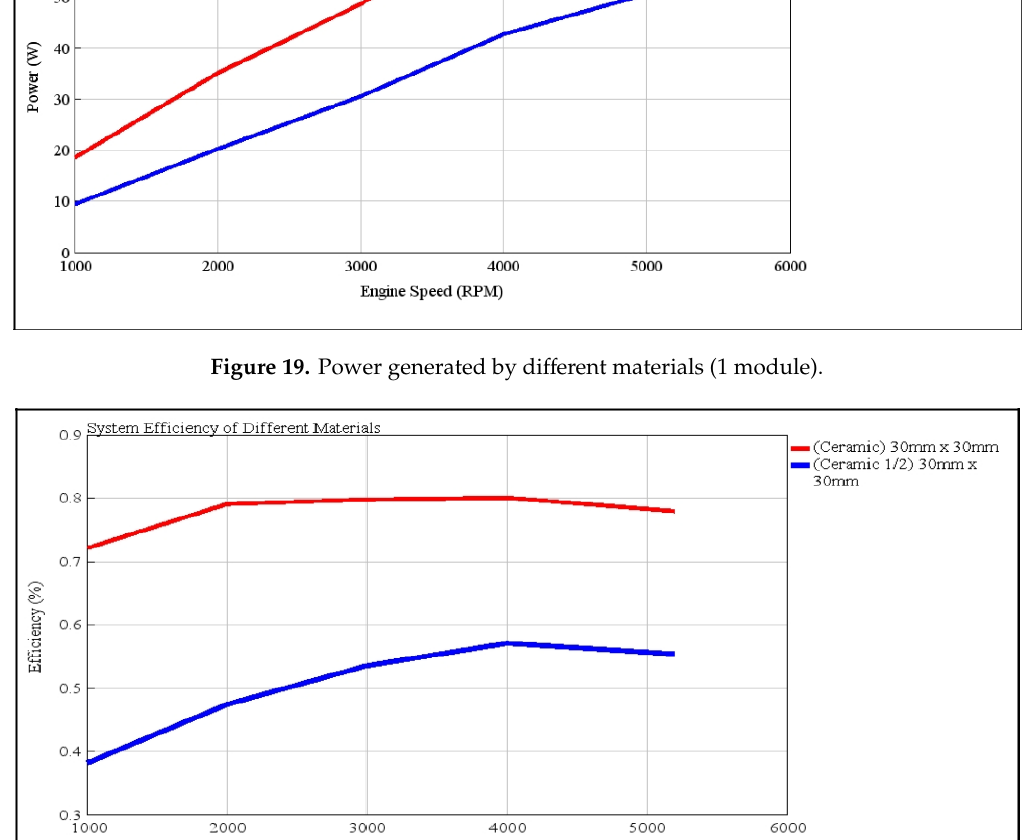
Table 3. Best option parameters for the TEG module.